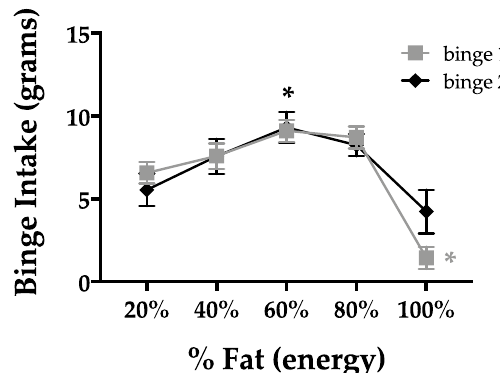
Figure 2. Rat binge-type eating across a spectrum of fat–carbohydrate contents. Binge-type eating in rats was highest at 60% fat (40% carbohydrate) and lowest at 80% fat (20% carbohydrate) compared to 20% fat (80% carbohydrate). * p < 0.05.